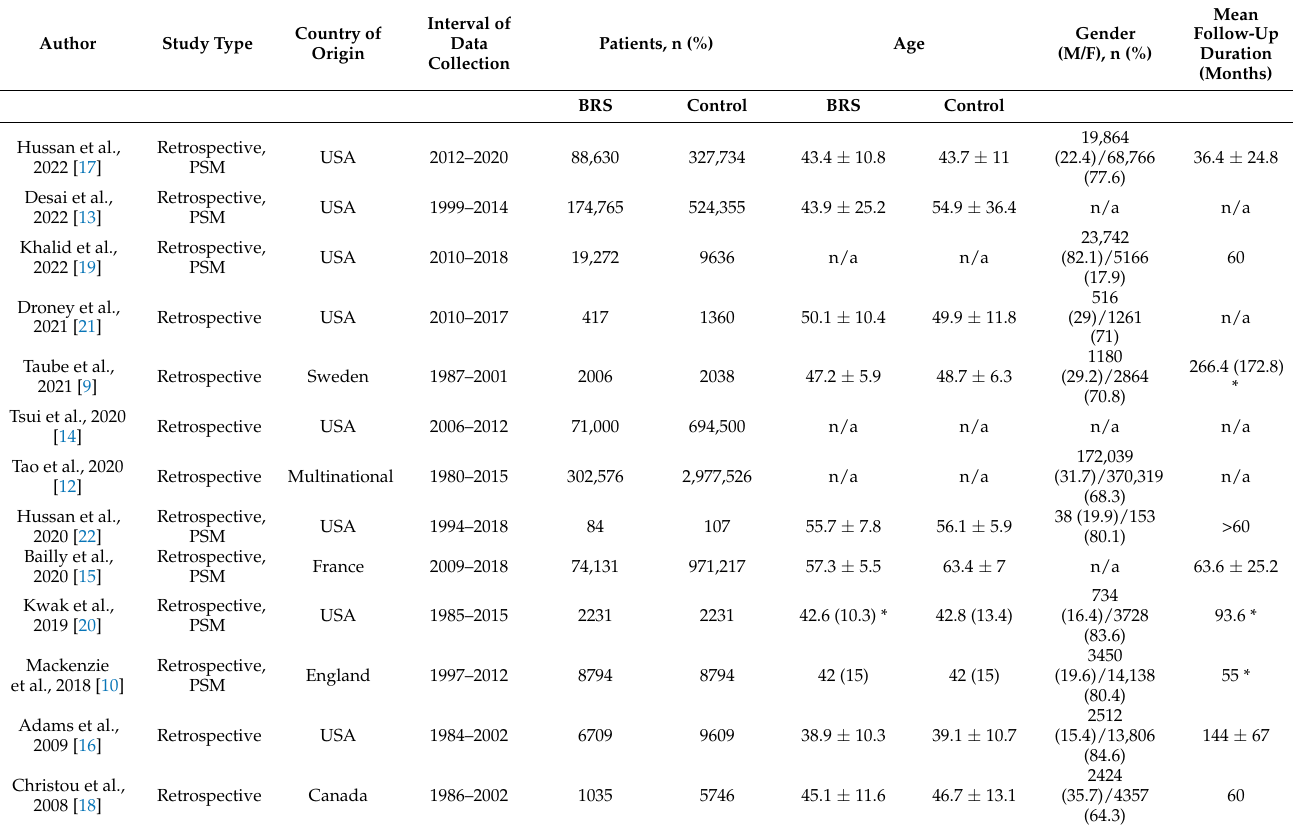
Table 1. Baseline study and patient demographics.